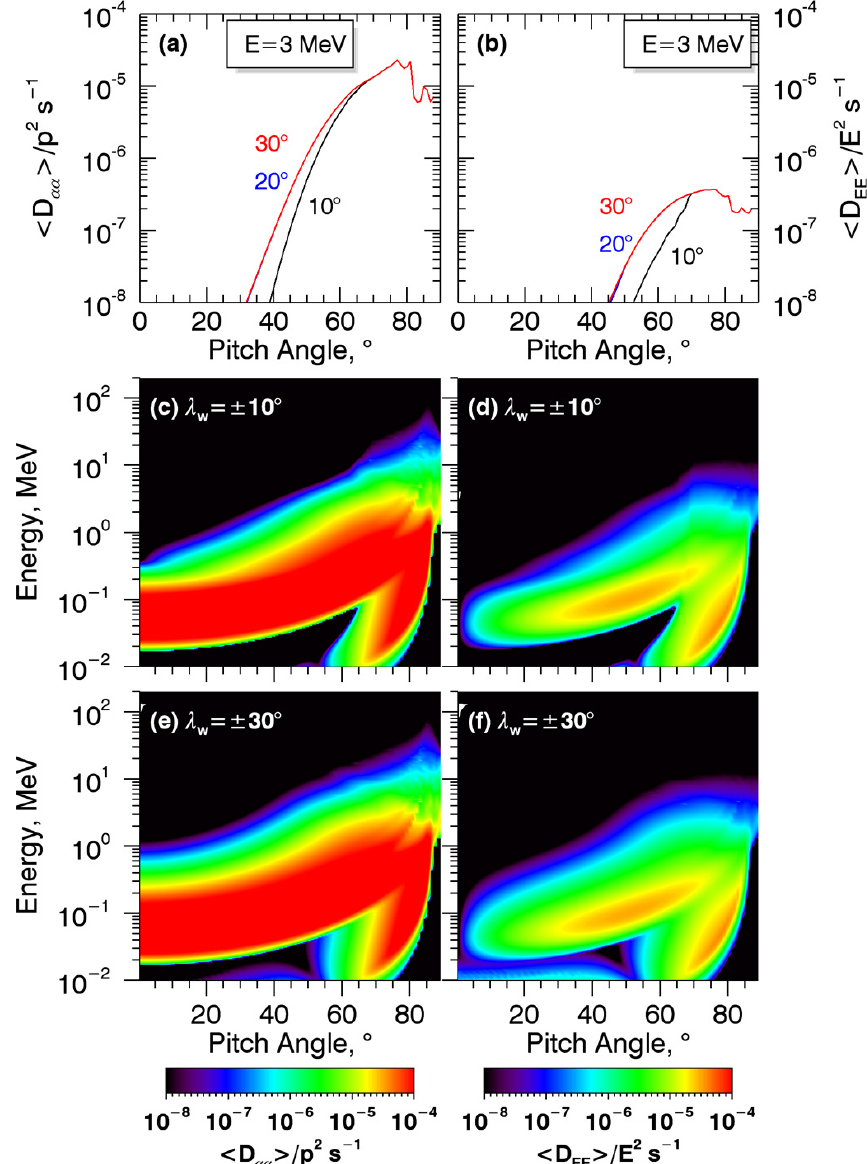
Fig. 6. Pitch angle and energy diffusion coefficients at L = 10 produced with chorus waves of varying intensity as a function of latitude and for different latitude ranges; left column: (a) shows < D αα > /p 2 at 3MeV (please note that the red and blue lines are overlapping), (c) variation of < D αα > /p 2 with energy for λ w = ± 10 ◦ and (e) same for λ w = ± 30 ◦ . Right column ( b , d and f ): same but for < D EE > /E 2